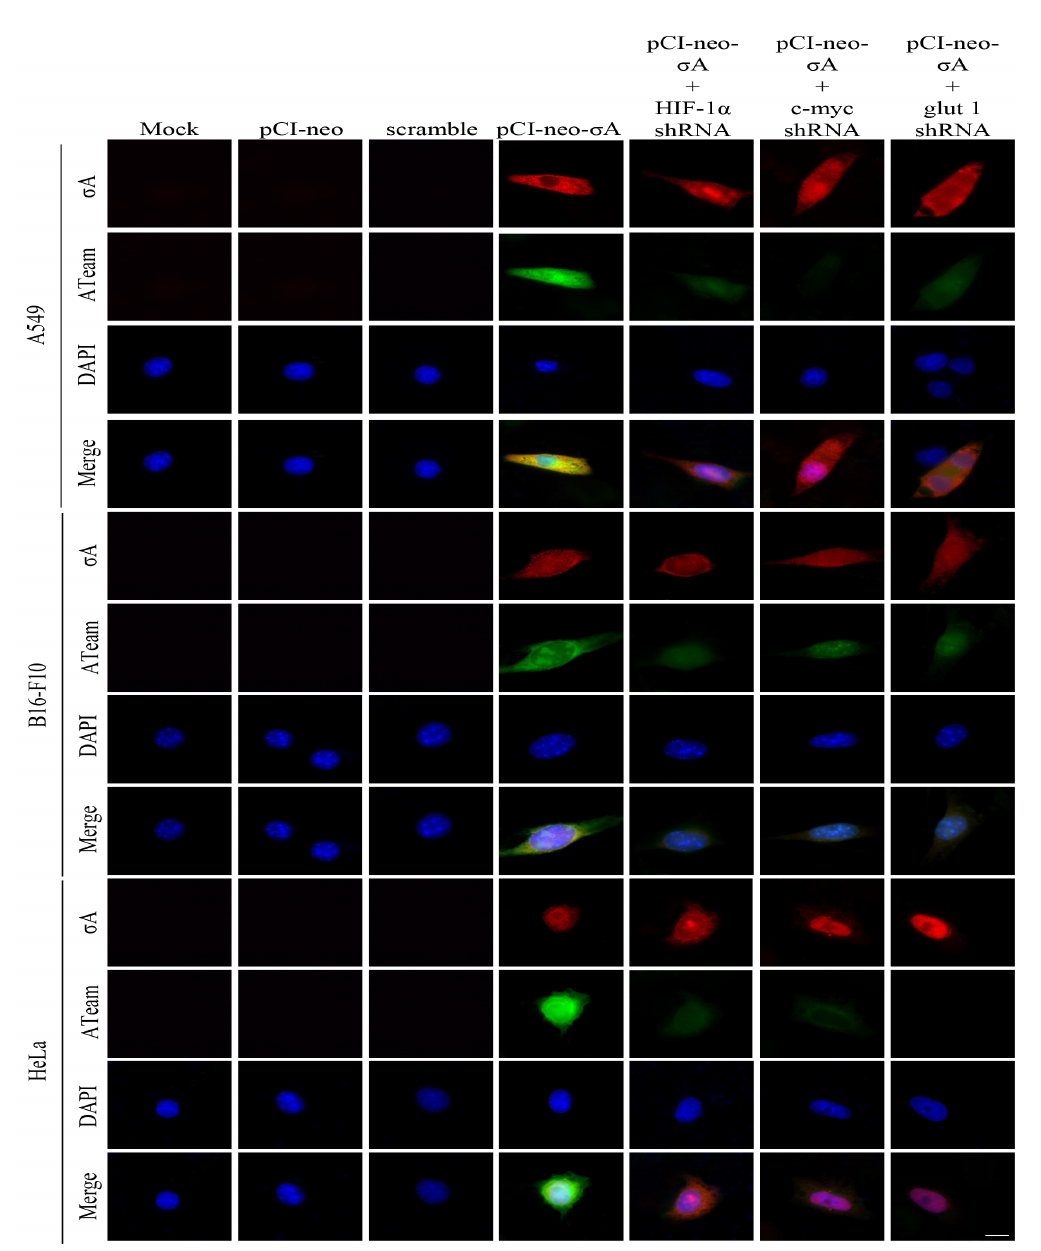
Figure 6. Visualization of adenosine triphosphate (ATP) levels inside cancer cell lines transfected with the pCI-neo- σ A plasmid. To measure intracellular ATP levels, A549, B16-F10, and HeLa cancer cell lines were co-transfected with ATeams and the pCI-neo- σ A plasmid with or without c-myc, HIF 1 α , and glut1 shRNAs for 24 h. The cells were observed and photographed with a fluorescence microscope (scale bar, 20 µ m). The fluorescence density was quantitated using Image J software as shown in Supplementary Figure S8B.